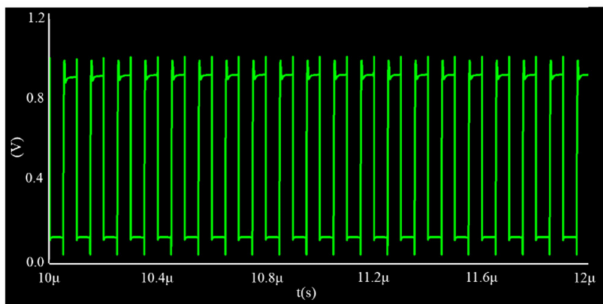
Figure 8. The gate voltage of M1 with the fault of GO of